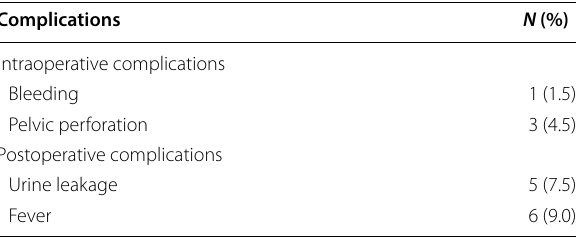
Table 2 Intra- and postoperative